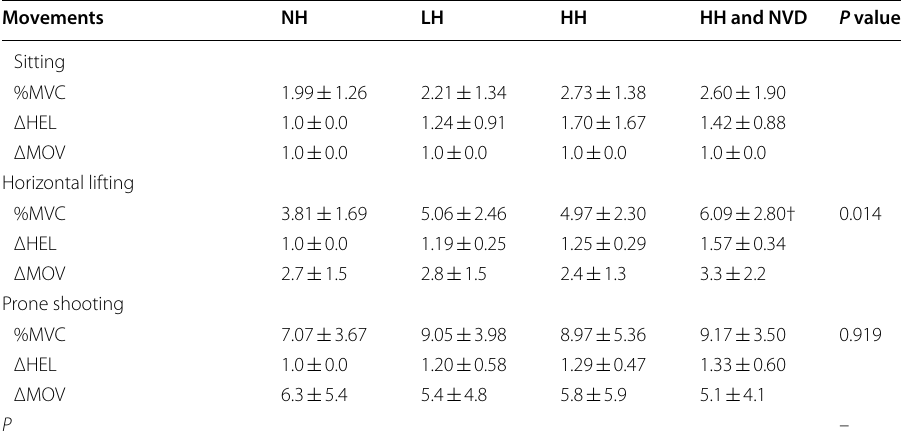
Table 2 Effect of the total helmet weight on the muscle strain of the left splenius capitis during sitting, horizontal lifting and prone shooting described as changes in %MVC ( N